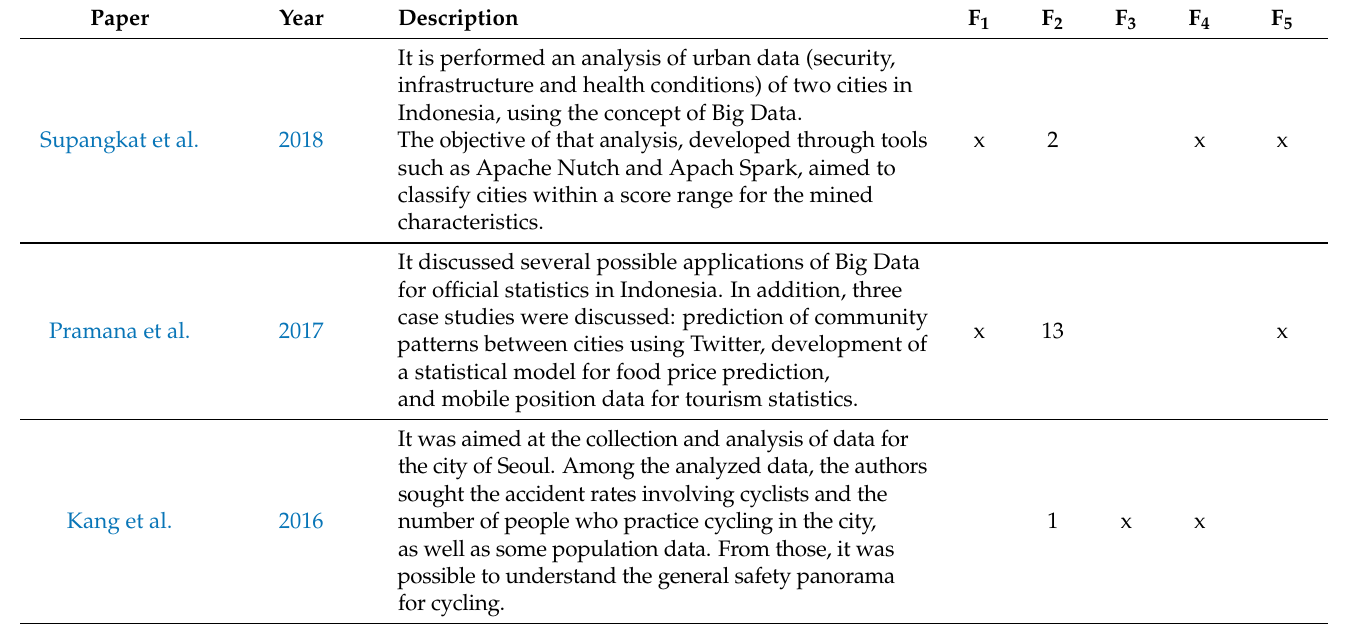
Table 2. Works focused on monitoring cycle paths conditions through the collection of statistical data from cities and/or tracks on the Internet. Statistical data collection approach features: F 1 —automated data collection, F 2 —number of cities considered in the research, F 3 —considers data from accidents involving cyclists, F 4 —considers cycle paths infrastructure data, F 5 —considers urban security